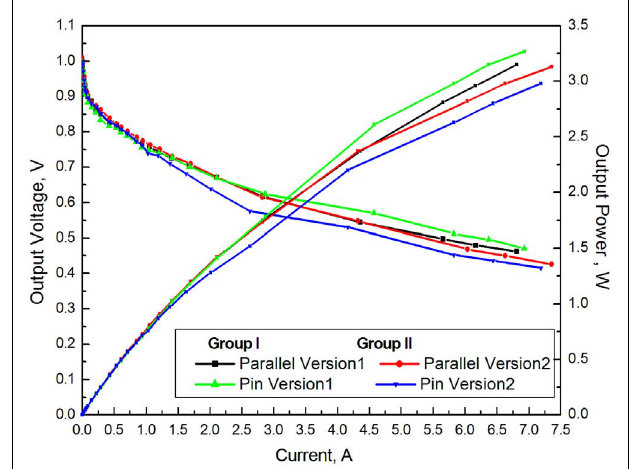
FIGURE 8 | Comparison of the voltage and power output for fuel cells with two types of parallel flow channels and their evolved pin versions of flow fields .